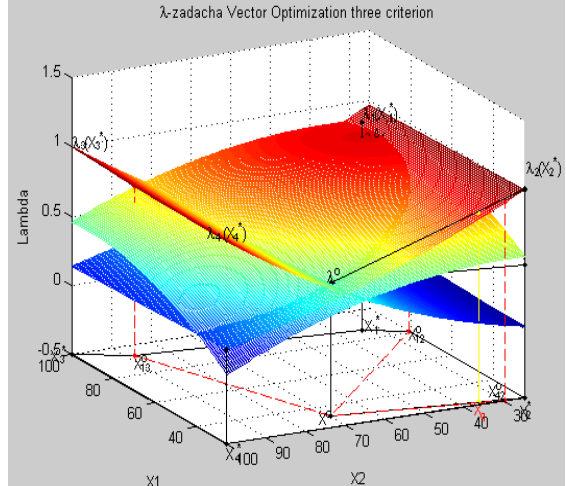
Figure 8. The solution of the λ -problem (1, 2, 3 criterion) in a three-dimensional system of coordinates of x1, x2 and λ